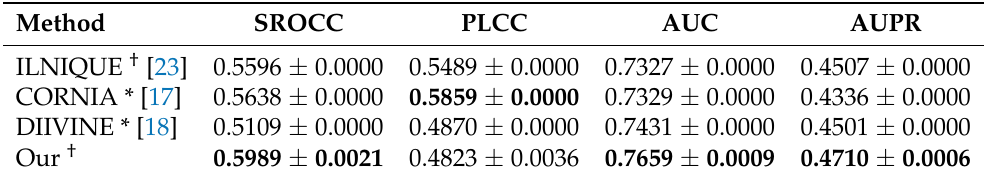
Table 3. Pearson’s Linear Correlation Coefficient (PLCC), Spearman’s Rank-order Correlation Co- efficient (SROCC) area under the receiver operating characteristic curve (AUC) and the area under the precision-recall curve (AUPR) of the proposed solution respect the three state of the art methods (ILNIQUE, CORNIA, DIIVINE). In each column, the best values are marked in boldface.